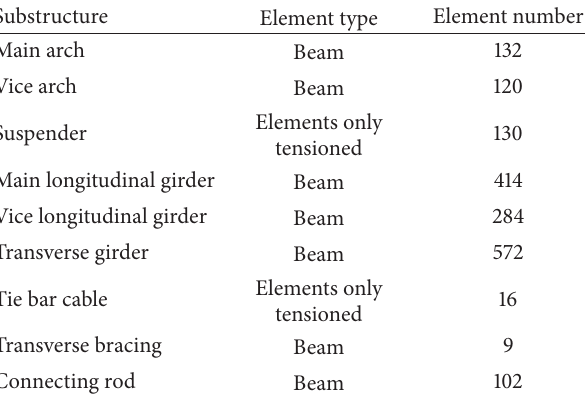
Table 8: Element types and numbers in FE model.